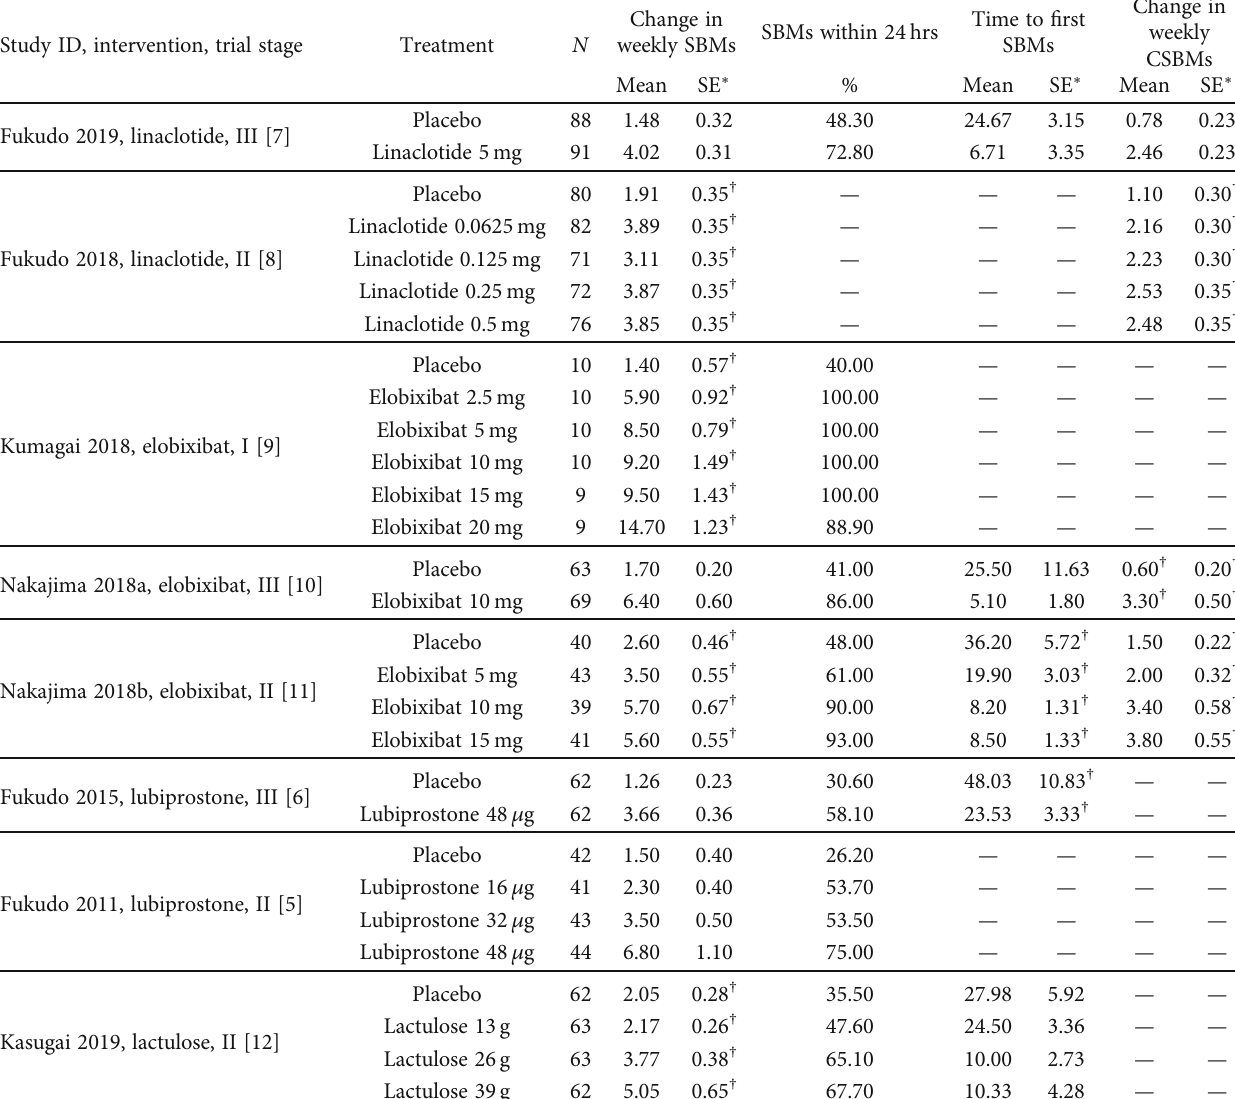
Table 2: Extracted information for